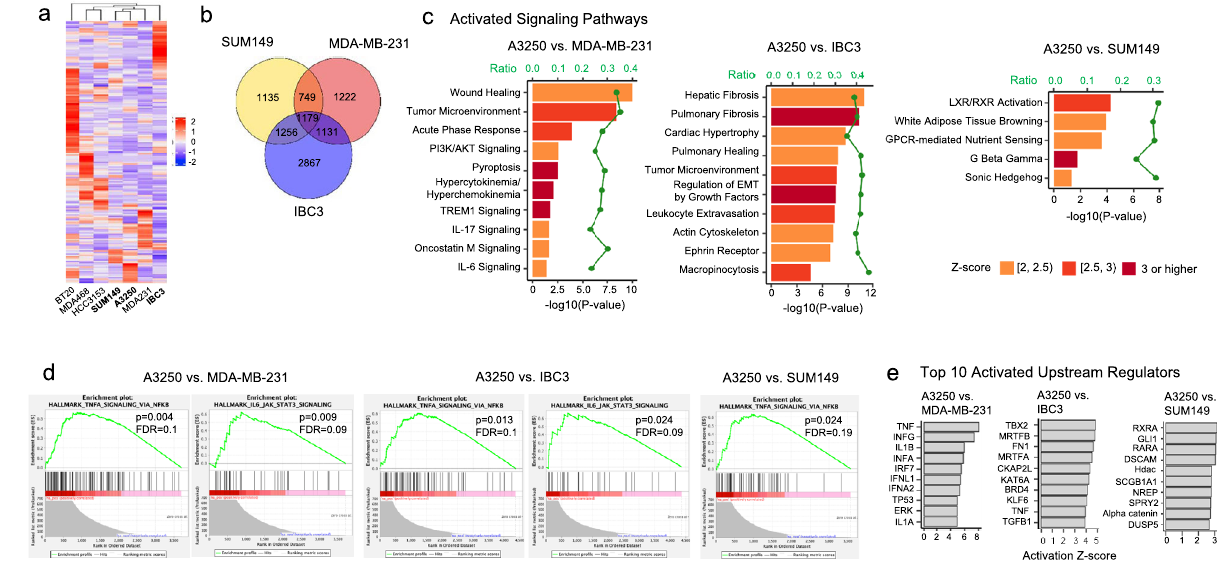
Fig. 3 Transcriptional pro fi le of A3250 compared to MDA-MB-231, IBC3 and SUM149 cells. a Hierarchical clustering of 175 top differentially expressed genes (DEGs) by mRNA-Seq between A3250, IBC3, and SUM149 IBC cells and several non-IBC cell lines. IBC cell lines are in bold. Z -score is indicated. b Venn diagram of DEGs in A3250 compared to MDA-MB-231, SUM149, and IBC3. c Pathways activated in A3250 in comparison to MDA-MB-231, IBC3, and SUM149 by IPA. d Selected Gene Set Enrichment Analyses (GSEA) for gene sets enriched in A3250 compared to MDA-MB-231, IBC3, and SUM149. e Upstream regulators differentially activated in A3250 compared to MDA-MB-231, IBC3, and SUM149, determined by